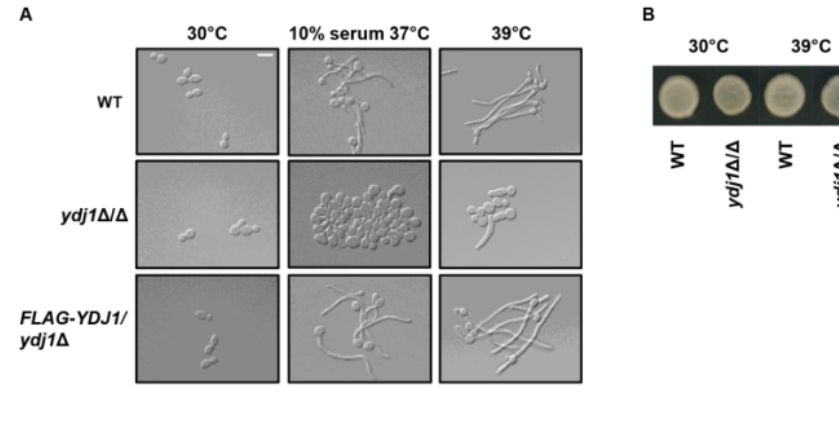
FIGURE 2: Ydj1 is required for adapta- tion to high